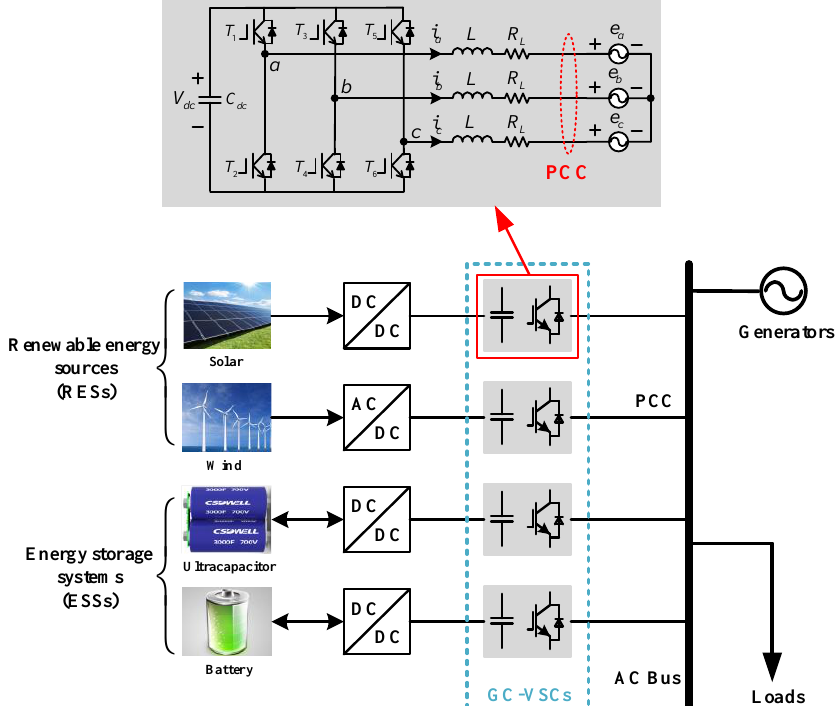
Figure 1. The configuration of a distributed power generation